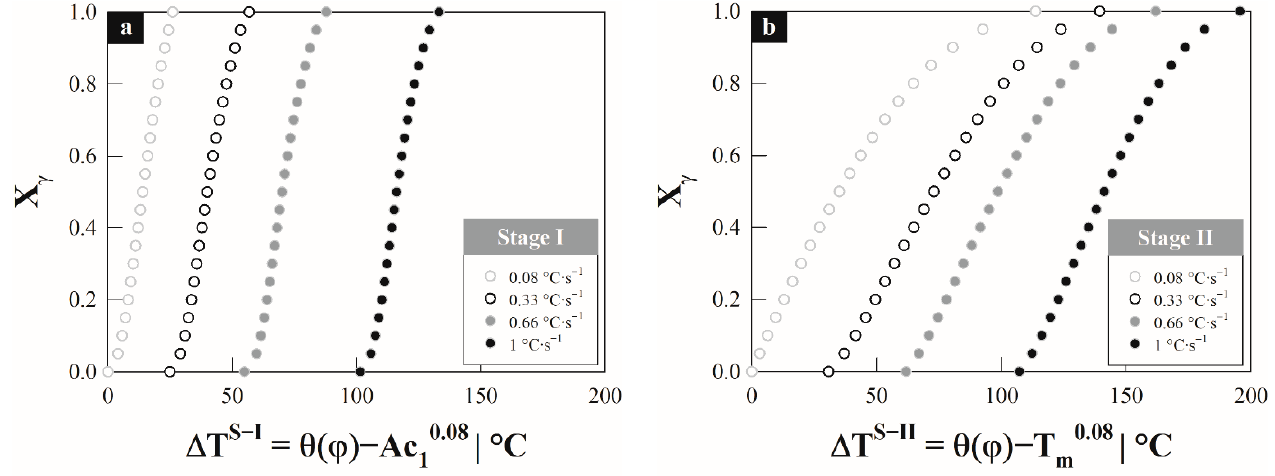
Figure 3. Austenite formation degree by stages as a function of overheating: ( a ) stage–I and ( b ) stage–II.